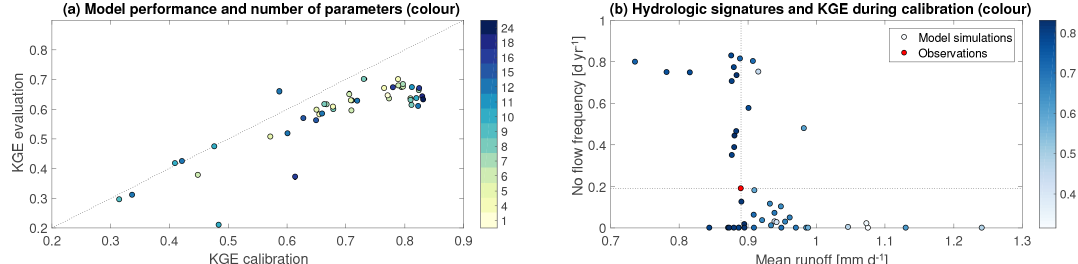
Figure 3. Example of MARRMoT application to Hickory Creek near Brownstown (USA). (a) Model performance during calibration (1989– 1998) and evaluation (1999–2009) periods. Each dot represents a single model and is coloured according to the model’s number of calibrated parameters. (b) Comparison of simulated average flow and no-flow frequency signature values and observed values for those signatures (red dot bisected with